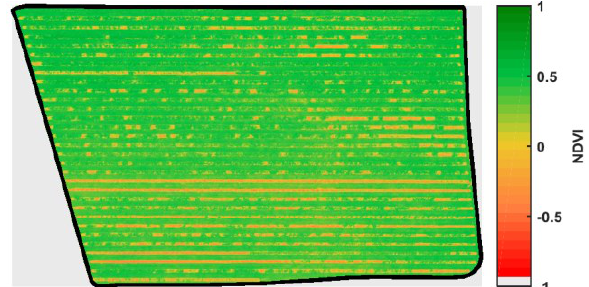
Figure 3. NDVI image computed from the red and NIR mosaics over orchard#1.